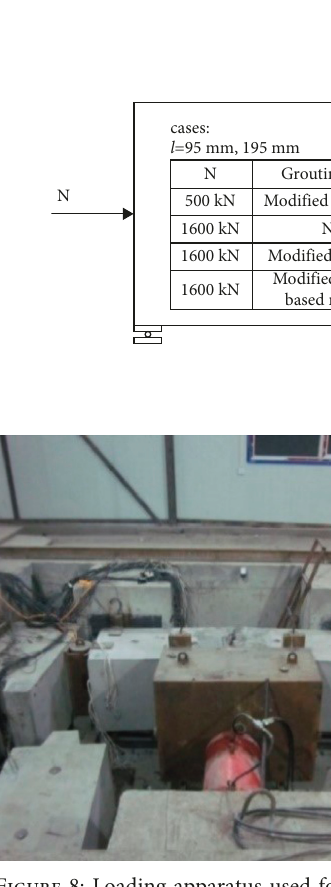
Figure 8: Loading apparatus used for specimen